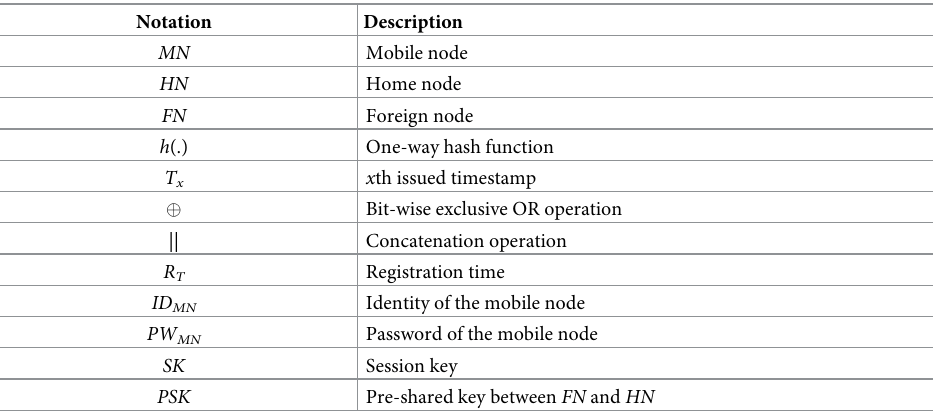
Table 1. Notation used in Ahmed et al.’s